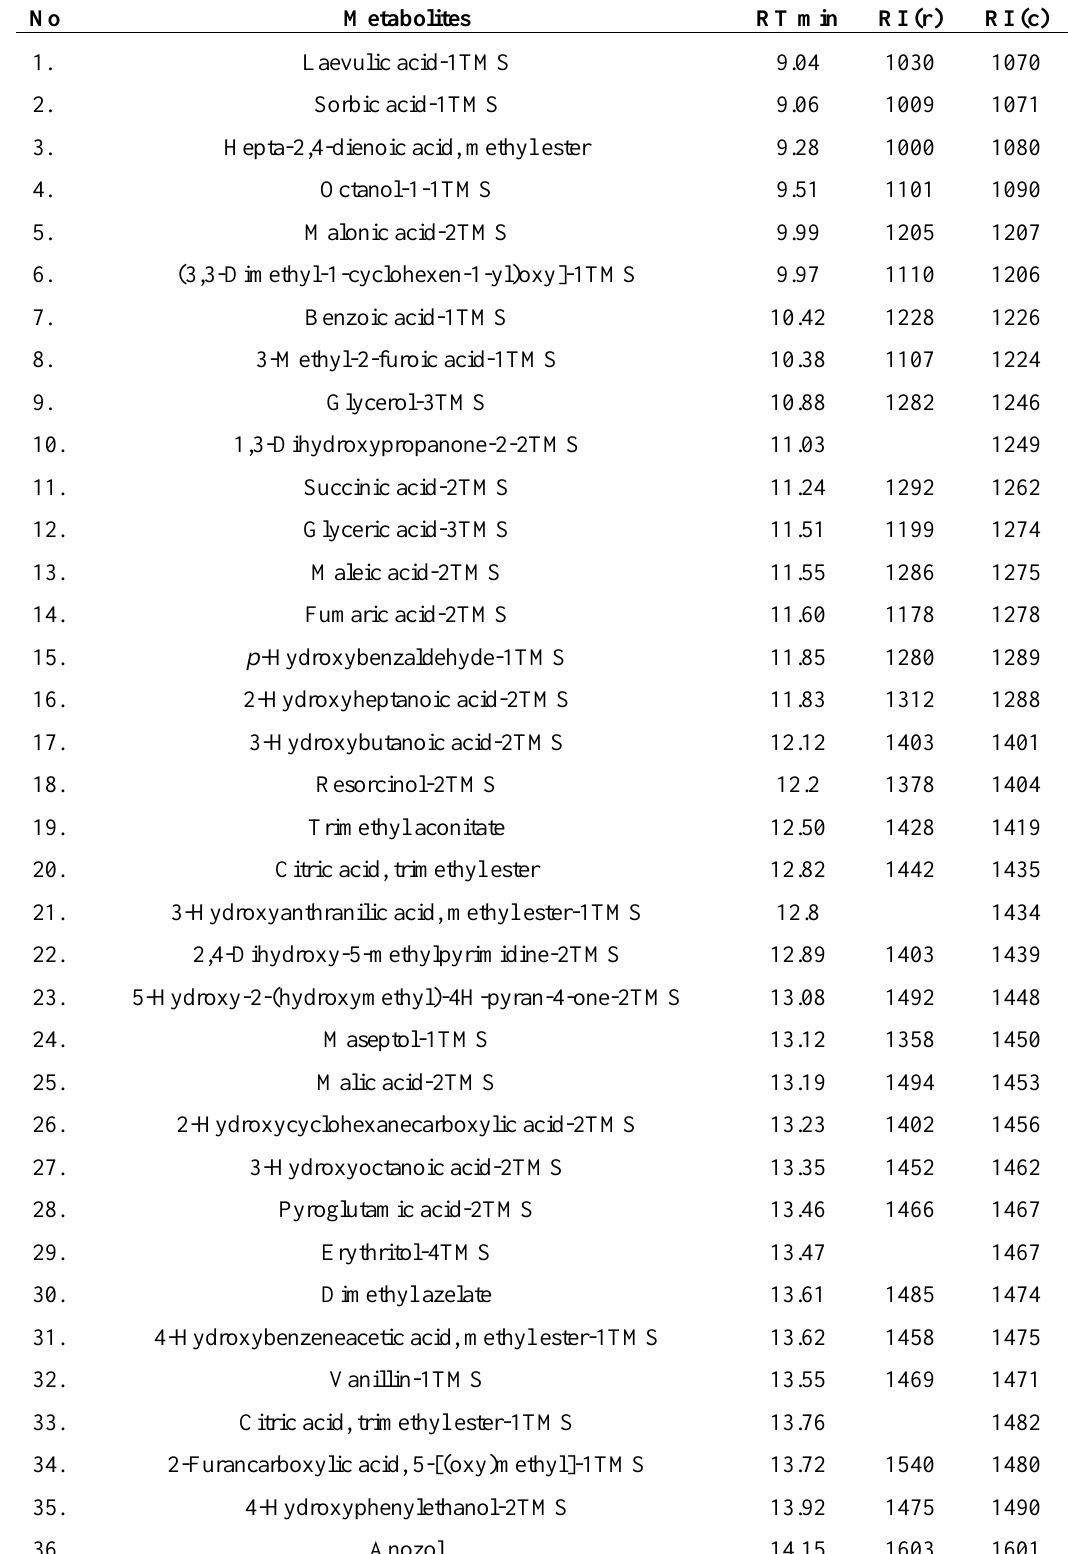
Table 1. A list of identified metabolites from wheat, barley, rye and oat flour samples by GC-MS. Metabolite identification was performed at level 2 as described in Metabolomics Standards Initiative report [34] and was based on RI and EI-MS library match (>80). a Metabolites with more than one isomers and/or TMS-derivatives; b tentatively